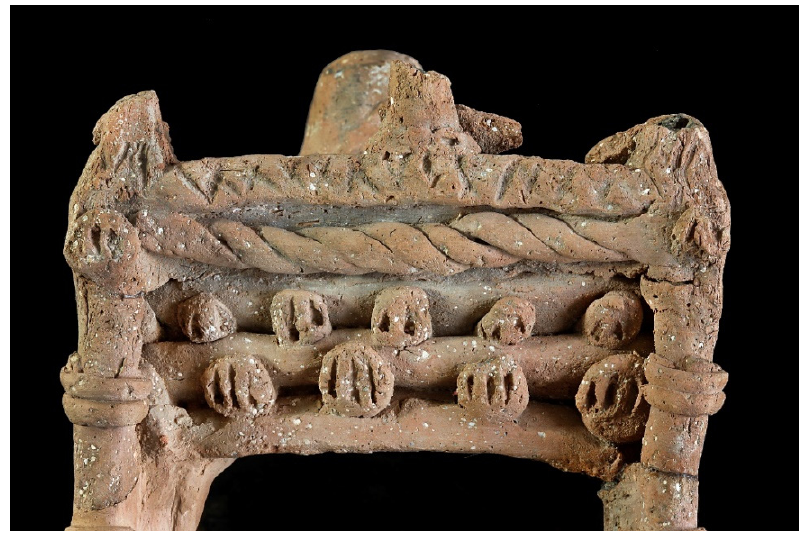
Figure 8. Close-up of the upper façade above the door of the clay portable shrine from Khirbet Qeiyafa (photograph by G. Laron). The twisted band probably represents a rolled textile that was hung from above the door.